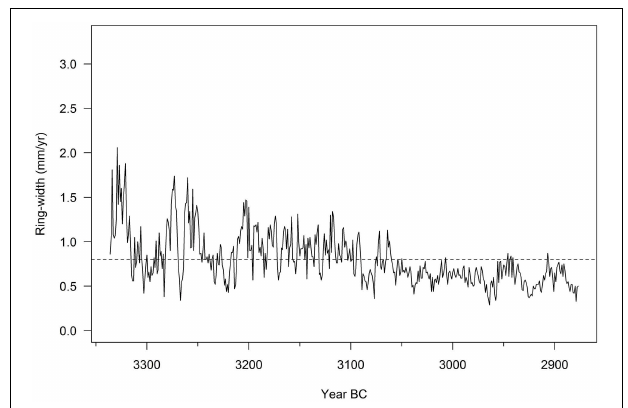
FIGURE 8 | Ring-width series of the “bog oak Methusalem,” one of the oldest central European sub-fossil bog oaks (3336–2877 BC). The sample has 460 tree rings, but sapwood was missing: estimated age is circa 500 years (courtesy of Dr. Hanns Hubert Leuschner). The dotted line represents the average ring width of the